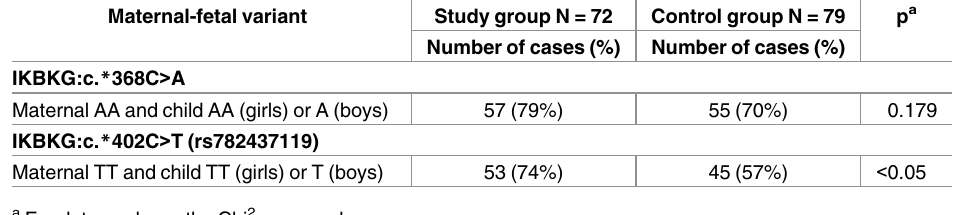
Table 4. Comparison of the simultaneous occurrence of an AA genotype in the mother and her child (AA in her daughter or A allele in her son) (IKBKG:c. * 368C > A),and the simultaneous occurrence of a TT genotype in the mother and her child (TT in her daughter, or T allele in her son) (IKBKG:c. * 402C >